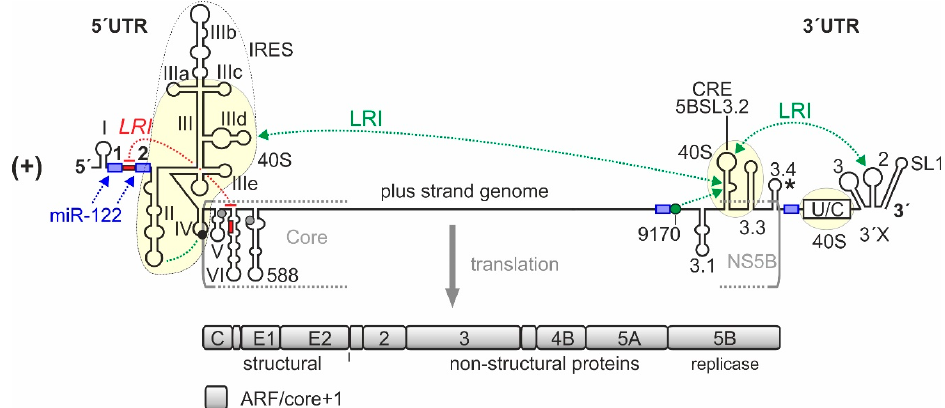
Figure 1. cis -Elements in the hepatitis C virus (HCV) RNA genome that are involved in translation regulation. The HCV plus strand RNA genome. The internal ribosome entry site (IRES) in the HCV 5´-untranslated region (5´UTR), the entire 3´UTR and the cis -acting replication element (CRE) in the NS5B coding region are involved in translation regulation [22–24]. Those regions of the 5´UTR, 3´UTR, and CRE that bind to the ribosomal 40S subunit are underlayed in light yellow. Stem-loops (SLs) in the 5´UTR are numbered by roman numerals. The region of the IRES is surrounded by a dotted line. The IRES includes SLs II–IV of the 5´UTR but spans into the core protein coding region. The canonical AUG start codon in SL IV of the 5´UTR (black circle) gives rise to translation of the polyprotein which is cleaved to yield structural proteins and non-structural (NS-) proteins, including the viral replicase NS5B. The 3´UTR contains the variable region, a poly(U/C) tract (U/C), and the so-called 3´X region including SLs 1, 2, and 3. The stem-loop 5BSL3.2 in the 3´-region of the NS5B coding region is the CRE, flanked by upstream stem-loop 5BSL3.1 and downstream 5BSL3.3. The polyprotein stop codon is located in the stem-loop 5BSL3.4 (asterisk). Some other start codons which give rise to the alternative reading frame (ARF) in the core+1 reading frame [25–28] are shown in grey. Positively and negatively acting long-range RNA–RNA interactions (LRIs) are shown in green or red, respectively, with the sequence “9170” shown as green circle. Selected binding sites for microRNA-122 (miR-122) are shown in blue.